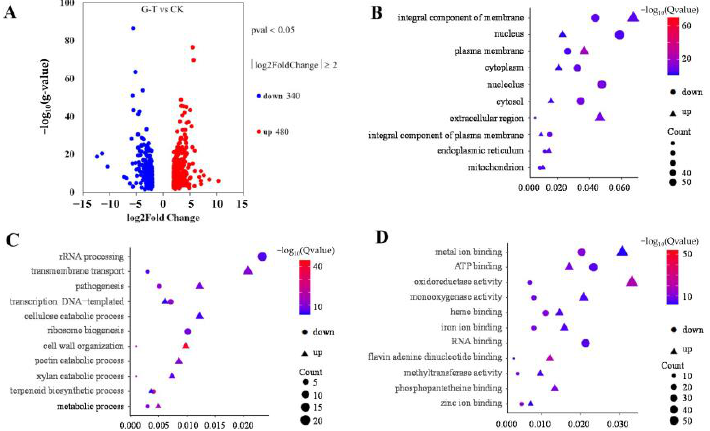
Figure 5. Volcano plots of differentially expressed genes (DEGs) in Aspergillus niger ( A ); bubble chart of cell components ( B ), biological processes ( C ), and molecular functions ( D ) of DEGs in GO enrichment analysis.